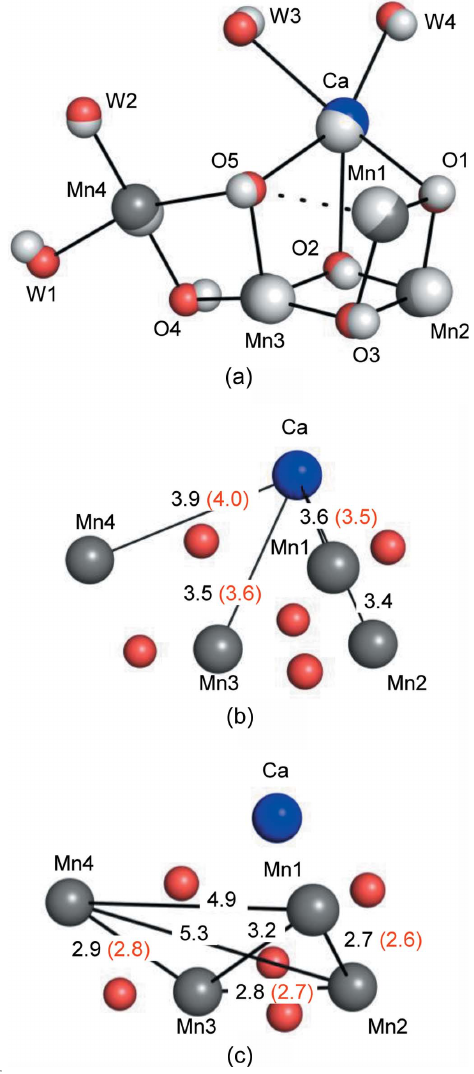
Figure 6 ( a )–( c ) OEC structures in the S 1 and S 2 states are shown as gray and colored atoms, respectively. Color codes: blue for calcium; cyan for manganese; red for oxygen. The color codes for the OEC are the same in all figures unless otherwise noted. In ( b ) and ( c ), interatomic distances are given in a˚ngstroms, with the numbers in black for S 1 and red for S 2 . The distances in the S 2 state were shown only when they were greater by more than 0.1 A˚ compared with the corresponding distances in the S 1